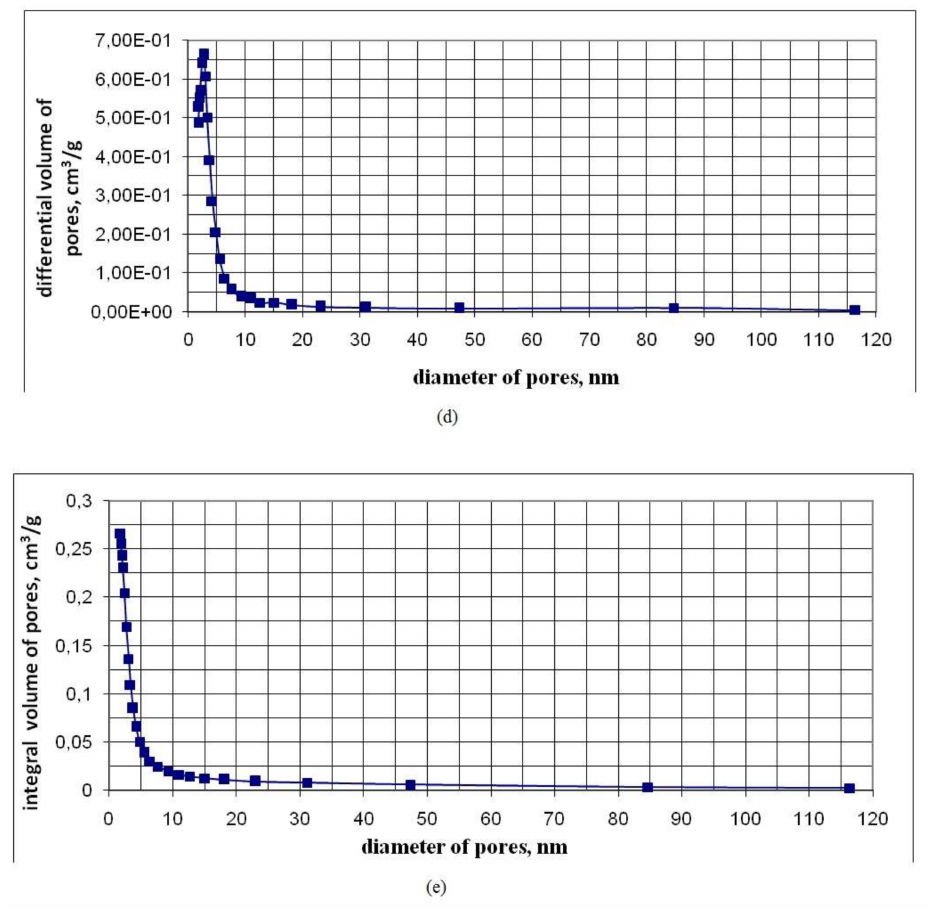
Figure 11. Pore characteristics of the UF-12-6 sample obtained by the low-temperature nitrogen adsorption method: ( a ) adsorption-desorption curves (p / p 0 —relative nitrogen pressure, p 0 —nitrogen saturation pressure at a temperature of 77 K); ( b ) di ff erential distribution of area over pore diameter; ( c ) integral distribution of the area along the pore diameter; ( d ) di ff erential distribution of volume over pore diameter; ( e ) integral distribution of volume by pore